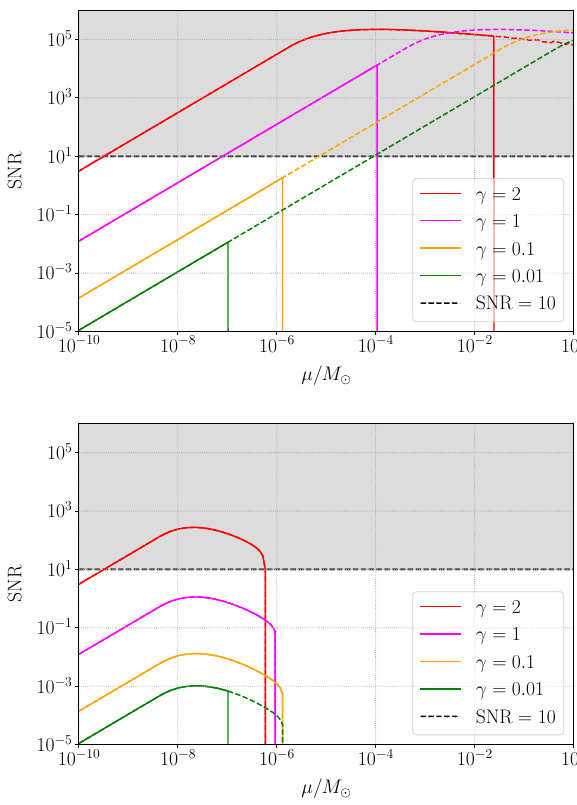
Fig. 2 Signal-to-noise ratio (SNR) for circular orbits macros of mass μ around SgrA ∗ . The underlying dark-matter distribution is the same as in Fig. 1. The upper panel shows results for τ min = 5years, while the lower panel utilises τ min = H − 1 . The gray band shows the region that 0 can be detected with SNR = 10 . In this figure, we assume the dark- matter fraction is f macro ≡ (cid:9) macro /(cid:9) DM = 1 . The solid lines represent regions where the signal is expected to be stochastic, while dashed lines represent an extrapolation of the stochastic sensitivity into a parameter space where individual sources may be resolvable